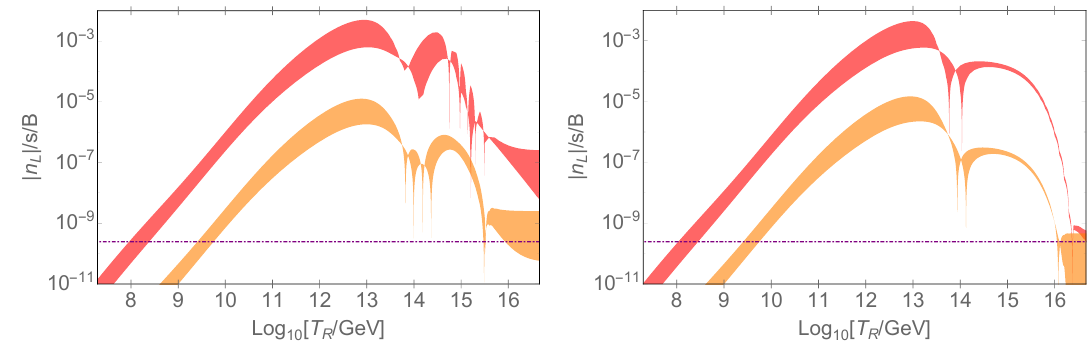
Figure 1 . The dependence of lepton asymmetry on the reheating temperature with (cid:11) M = 0 : 3 (cid:25) , (cid:14) = (cid:0) (cid:25)= 2, V = 1 p (1 ; 1 ; 1) with the normal (inverted) mass hierarchy with one massless neutrino, 3 m (cid:23) lightest = 0 eV, in the left (right) panel. The red and orange bounds represent m (cid:30) =T = 1 and 100, respectively. Each band corresponds to the variance of C = C 0 between 1 = 3 and 3. The purple line represents the required lepton asymmetry. The shaded region may be invalid as the e(cid:11)ective theory calculation.